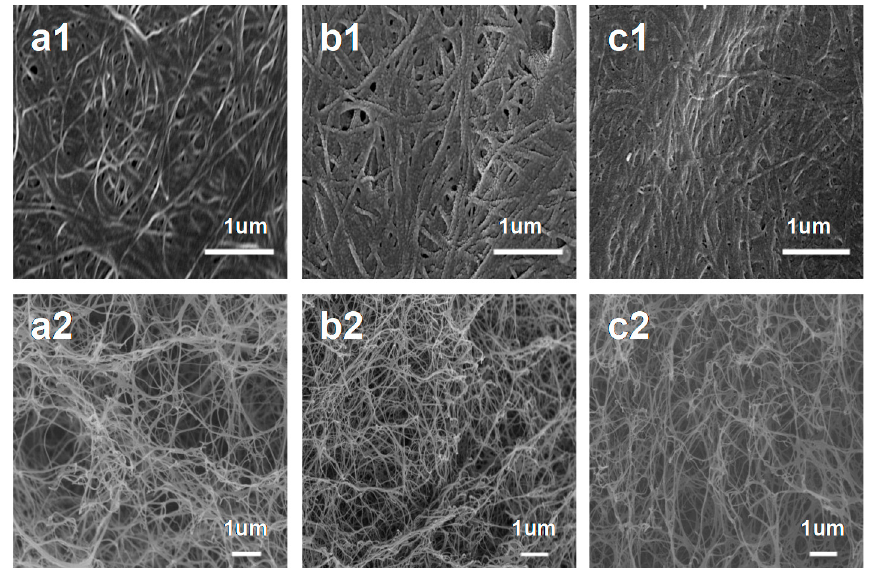
Figure 3. SEM image of ( a1 ) the surface and ( a2 ) the inner of N/P co-doped pyrolyzed bacterial cellulose (N/P-PBC), ( b1 ) the surface and ( b2 ) the inner of N/S co-doped pyrolyzed bacterial cellulose (N/S-PBC), ( c1 ) the surface and ( c2 ) the inner of N/P/S co-doped pyrolyzed bacterial cellulose (N/P/S-PBC).